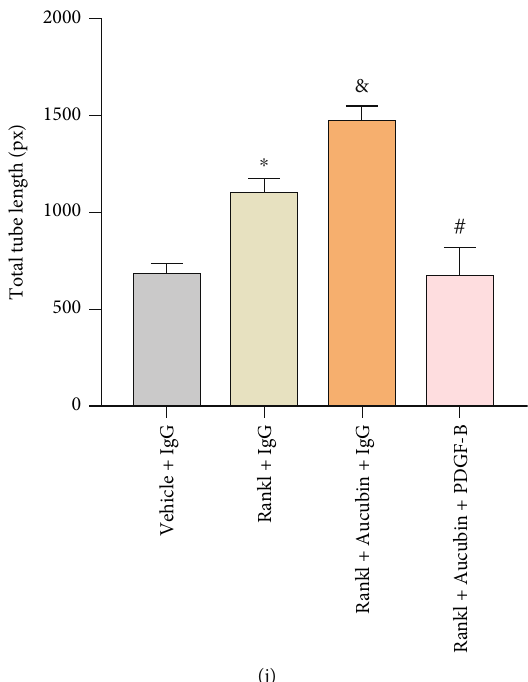
Figure 5: Aucubin promotes the proangiogenic e ff ects of preosteoclasts on MMECs. (a) Representative images of the migration area of MMECs in di ff erent treatments. Scale bar: 200 μ m. (b) The quanti fi cation of the migration area of MMECs in di ff erent treatments. Scale bar: 200 μ m. (c) Representative images of tube formation in MMECs stimulated with di ff erent treatments. Scale bar: 200 μ m. (d) The quanti fi cation of tube formation in MMECs stimulated with di ff erent treatments. (e) Relative mRNA expression levels of VEGF, MMP-9, and MMP-2 in MMECs with di ff erent CMs. (f) Concentration of VEGF in CM was analyzed by ELISA. (g) Representative images of the migration area of MMECs in di ff erent treatments. Scale bar: 200 μ m. (h) The quanti fi cation of the migration area of MMECs in di ff erent treatments. ∗ P < 0 : 05 compared to the vehicle+IgG group; & P < 0 : 05 compared to the Rankl+IgG group; # P < 0 : 05 compared to the Rankl+Aucubin+IgG group. (i) Representative images of tube formation in MMECs stimulated with di ff erent treatments. Scale bar: 200 μ m. (h) The quanti fi cation of tube formation in MMECs stimulated with di ff erent treatments. ∗ P < 0 : 05 compared to the vehicle+IgG group; & P < 0 : 05 compared to the Rankl+IgG group; # P < 0 : 05 compared to the Rankl+Aucubin+IgG